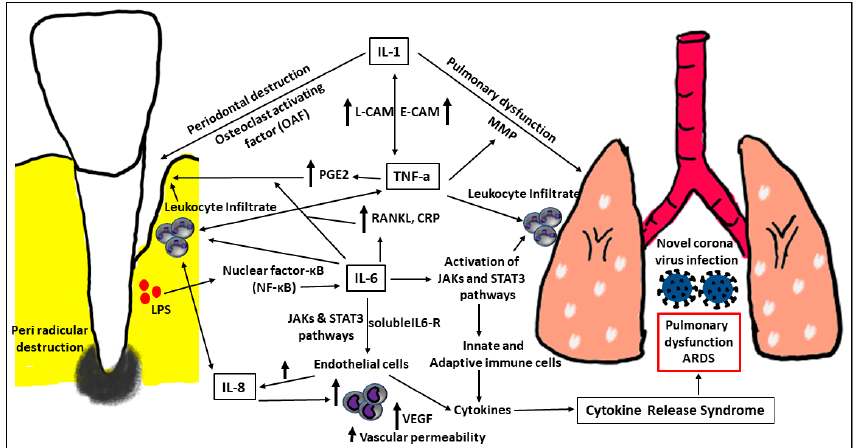
Figure 1. Cytokines released in pathogenesis of periodontal disease and the novel coronavirus infection. Figure legends: IL—Interleukin; L-CAM—Leukocyte cell adhesion molecules; E-CAM- Endothelial cell adhesion molecules; MMP—Matrix metalloproteinases; TNF—Tumor necrosis factor; PGE—Prostaglandin E; RANKL—Receptor activator of nuclear factor kappa-B Ligand; CRP—C-reactive protein; JAK—Janus Kinases; STAT—signal transducer and activator of transcription; VEGF—Vascular endothelial growth factor; LPS- Lipopolysaccharide.